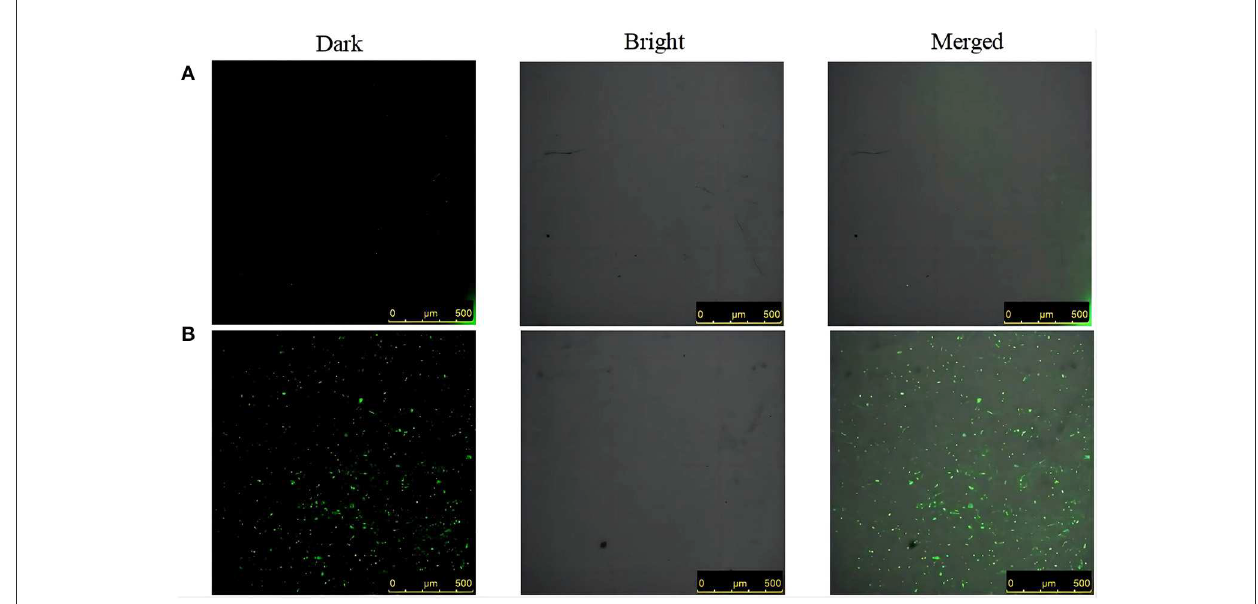
FIGURE5 Differences in the green fluorescence of ROS. (A) 0 × MIC group treated with 0.3% DMSO for 30min; (B) 8 × MIC group treated with SGCH for 30min. From left to right are dark field, light field and merged